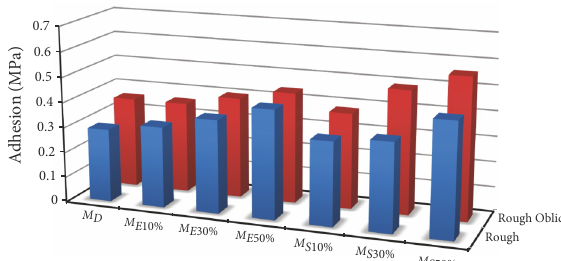
Figure 5. Evlution of the bond stress during 28 d of storage in different environments with water saturation of the substrate: mortar with sanitary ceramic waste